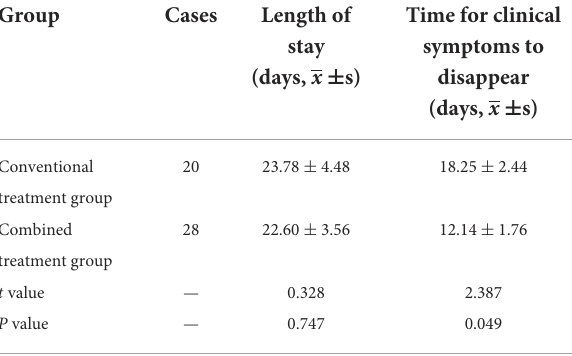
TABLE 2 Comparison of length of stay and time for clinical symptoms to disappear between the groups. Group